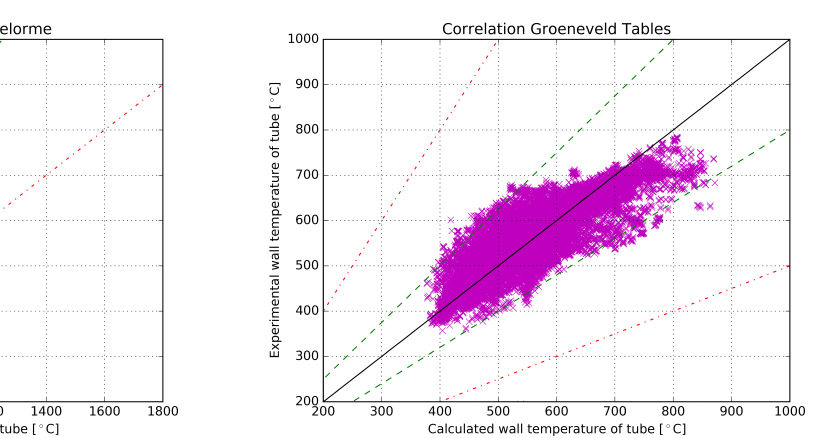
Figure 3. Comparison of experimental and calculated values of wall temperature with selected data from run with highest pressure and mass flux.